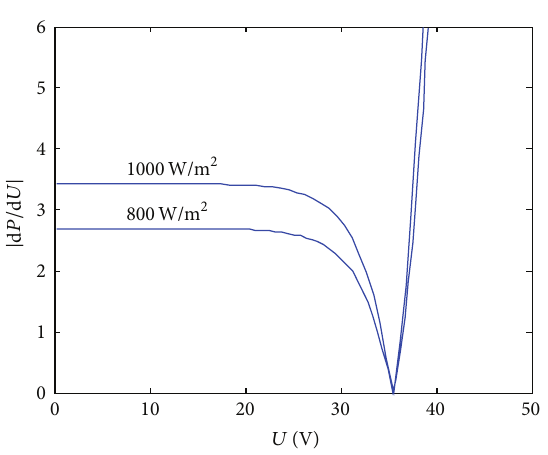
Figure 9: Relation curve of | d 𝑃/ d 𝑈| against voltage U .